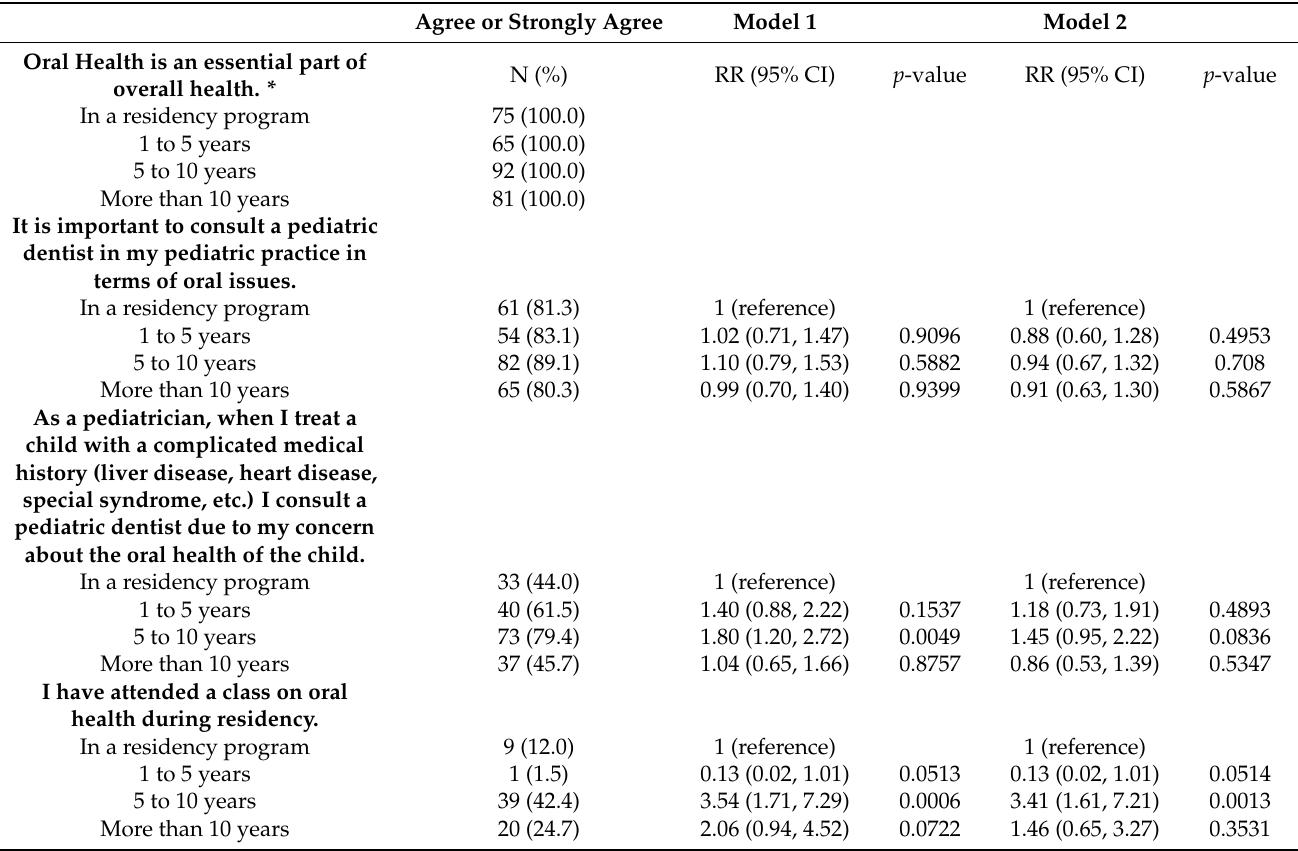
Table 2. Dentistry attitude, knowledge, and solution questions according to experience with regression